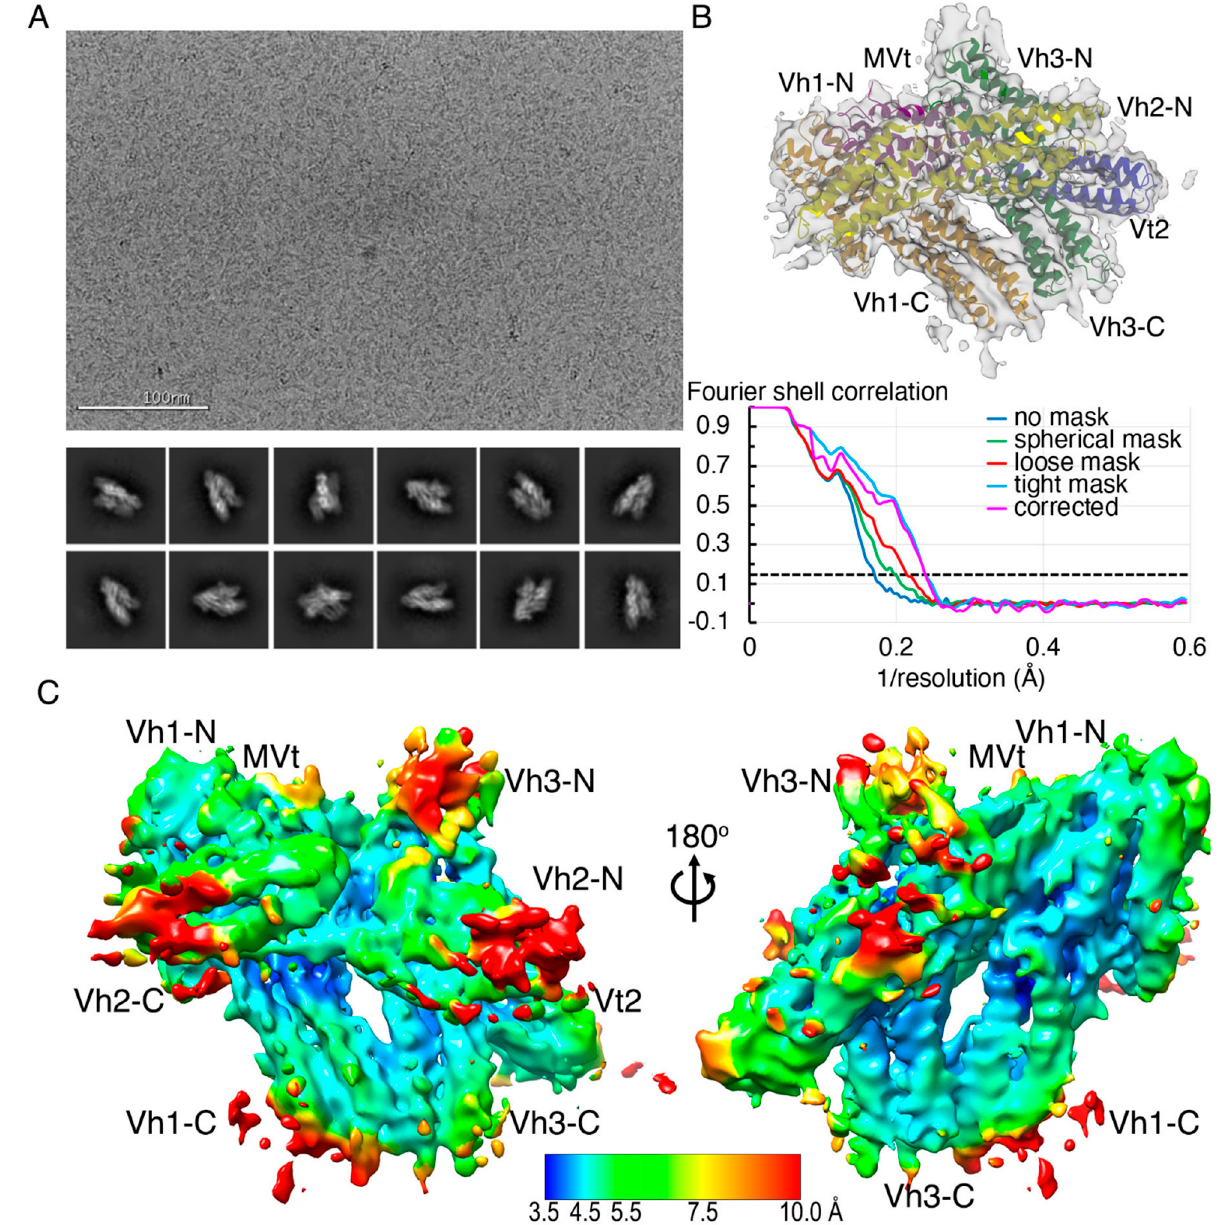
Figure 2. Cryogenic electron microscopy model of full-length metavinculin. ( A ). Top panel, Representative aligned and motion corrected images for metavinculin particles. Bottom panel, Representative two-dimensional classes for metavinculin particles exhibiting visible helix bundle features. ( B ) Top panel, The 4.17 Å metavinculin structure as obtained using all particles is depicted with the docked full-length human metavinculin structure color coded spectrally (Vh1, orange; Vh2, yellow; Vh3, green; Vt2, blue; MVt, violet). Bottom panel, The gold standard Fourier shell correlation curve using a 0.143 Å threshold, as obtained from homogeneous refinement from all particles, is provided for our final 4.17 Å metavinculin structure. ( C ) Local resolution map to show the overall resolution coverage along the entire metavinculin structure. The scale bar is color coded from high (3.5 Å, blue) to low (10 Å, red) resolution.